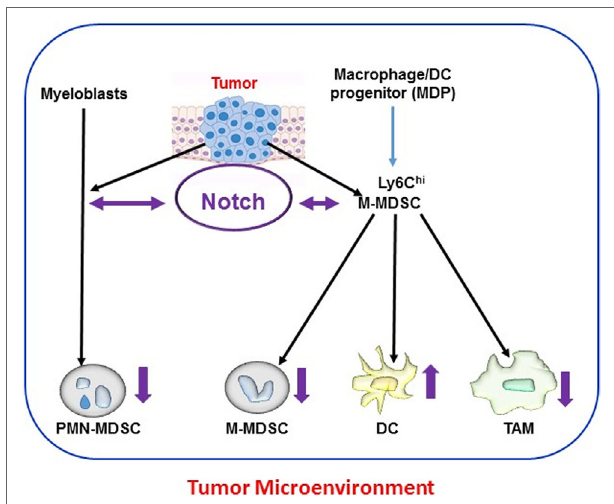
FigURe 1 | Notch and myeloid cells differentiation within tumor microenvironments. Myeloid cells [polymorphonuclear (PMN) cells, dendritic cells (DCs), and macrophages] derive from hematopoietic stem cells through common myeloid progenitors and the granulocyte-myeloid progenitors lineage. In tumor-bearing hosts, this differentiation process is altered by tumor-derived signals. Expansion of activated PMN-MDSC and M-MDSC occurs from myeloblasts and M-MDSC, respectively, during tumorigenesis. M-MDSC also differentiate into tumor-associated macrophages (TAMs) and DC at the tumor site. Notch signaling mediates bidirectional crosstalk at multiple steps of myeloid cells differentiation in the tumor microenvironment. Differential Notch expression and activity (as indicated by the direction of purple arrows) has been reported in different myeloid populations, with lower Notch expression in myeloid-derived suppressor cell (MDSC) and TAM and higher expression in